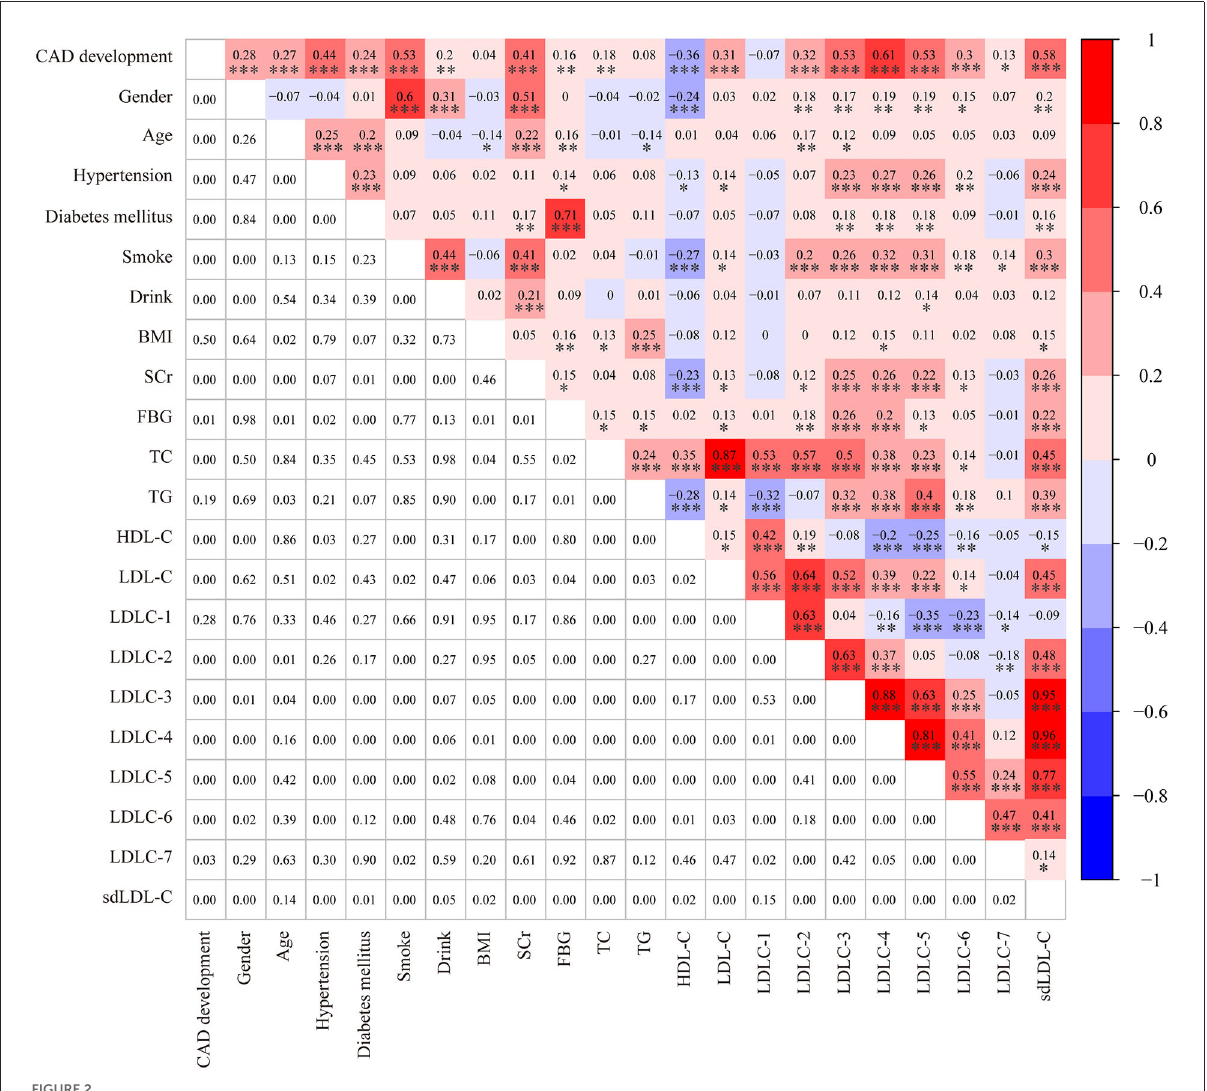
(25.27 vs. 10.91%, P = 0.003) history in patients with CAD than